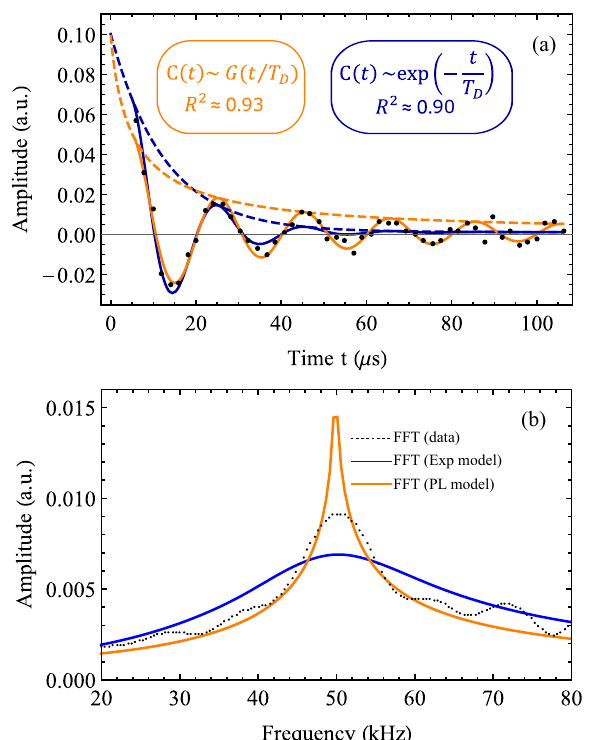
Fig. 2 Experimental data from correlation spectroscopy measure- ment with a single NV centre. ( a ) Signal of the correlation spectroscopy measurement as a function of the time difference between the two DD sequences (black dots) and fi ts of the exponential (blue line) and power-law (orange line) models. Labels show the goodness of fi t. The power-law model, described by Eq. (12), offers a better fi t to the data, which can be appreciated also in the C ( t / T D ) envelope (dashed lines). In both models, the initial amplitude for the fi tting algorithm is fi xed, obtained from an independent estimate in a power spectrum measurement. ( b ) Fast Fourier transform (FFT) of the experimental data together with FFT from the fi tted data in ( a ) to the exponential and the power-law decay models, shown for illustrative purposes. The sharpness displayed by the power-law model allows for a more precise frequency estimation than the exponential